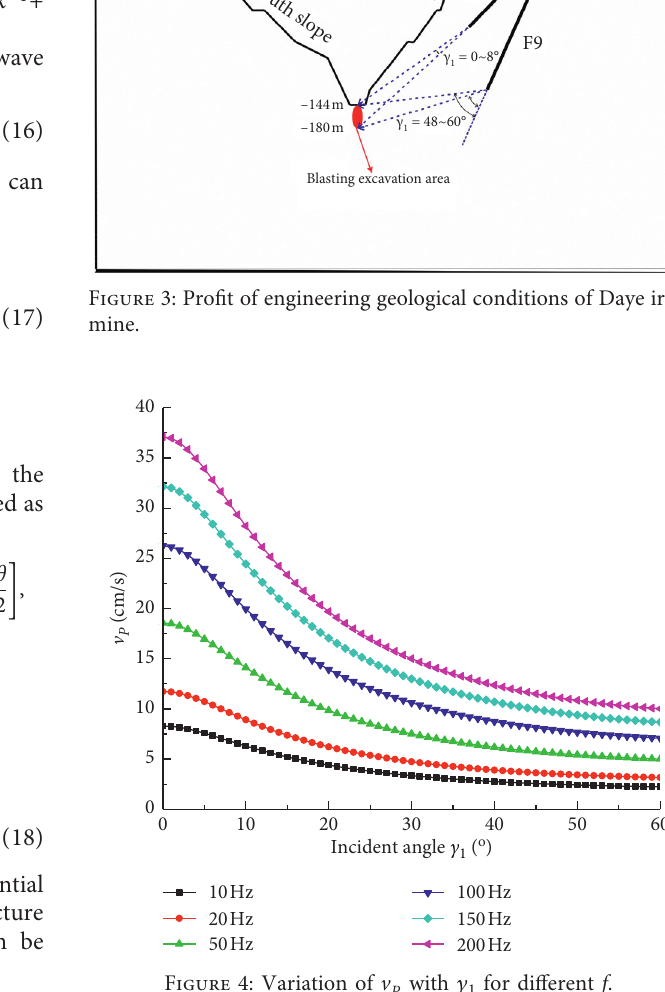
c P with 1 for different f